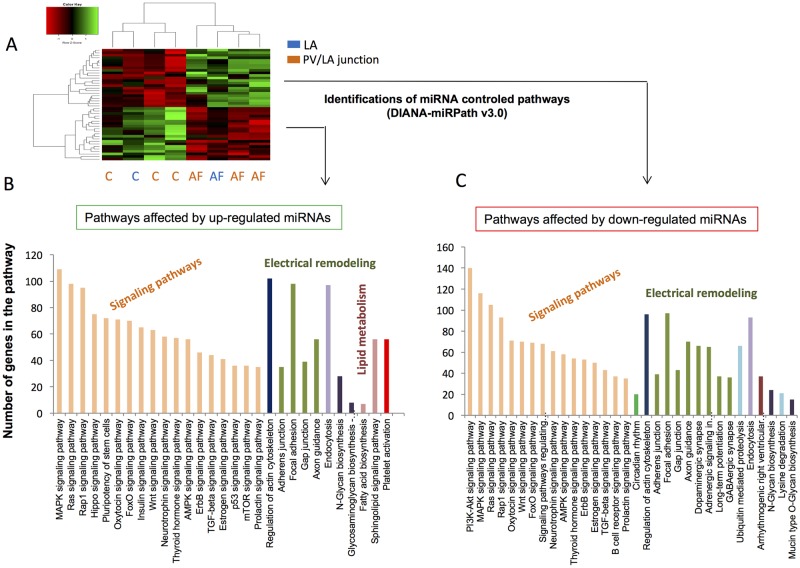
Predictions of miRNA controlled pathways affected by the up- or down-regulated miRNAs in left atria (LA) from patients suffering from atrial fibrillation (AF).A) Unsupervised hierarchical clustering and heat-map of the 42 miRNA basal expressions, altered in patients with AF or without AF (C = Controls). LA = biopsies from LA; PV/LA = biopsies from pulmonary vein-LA junction. B) and C) Significantly enriched KEEG pathways with target genes of the 42 altered miRNAs. Pathway predictions are from DIANA-miRPath v3.0 [45].